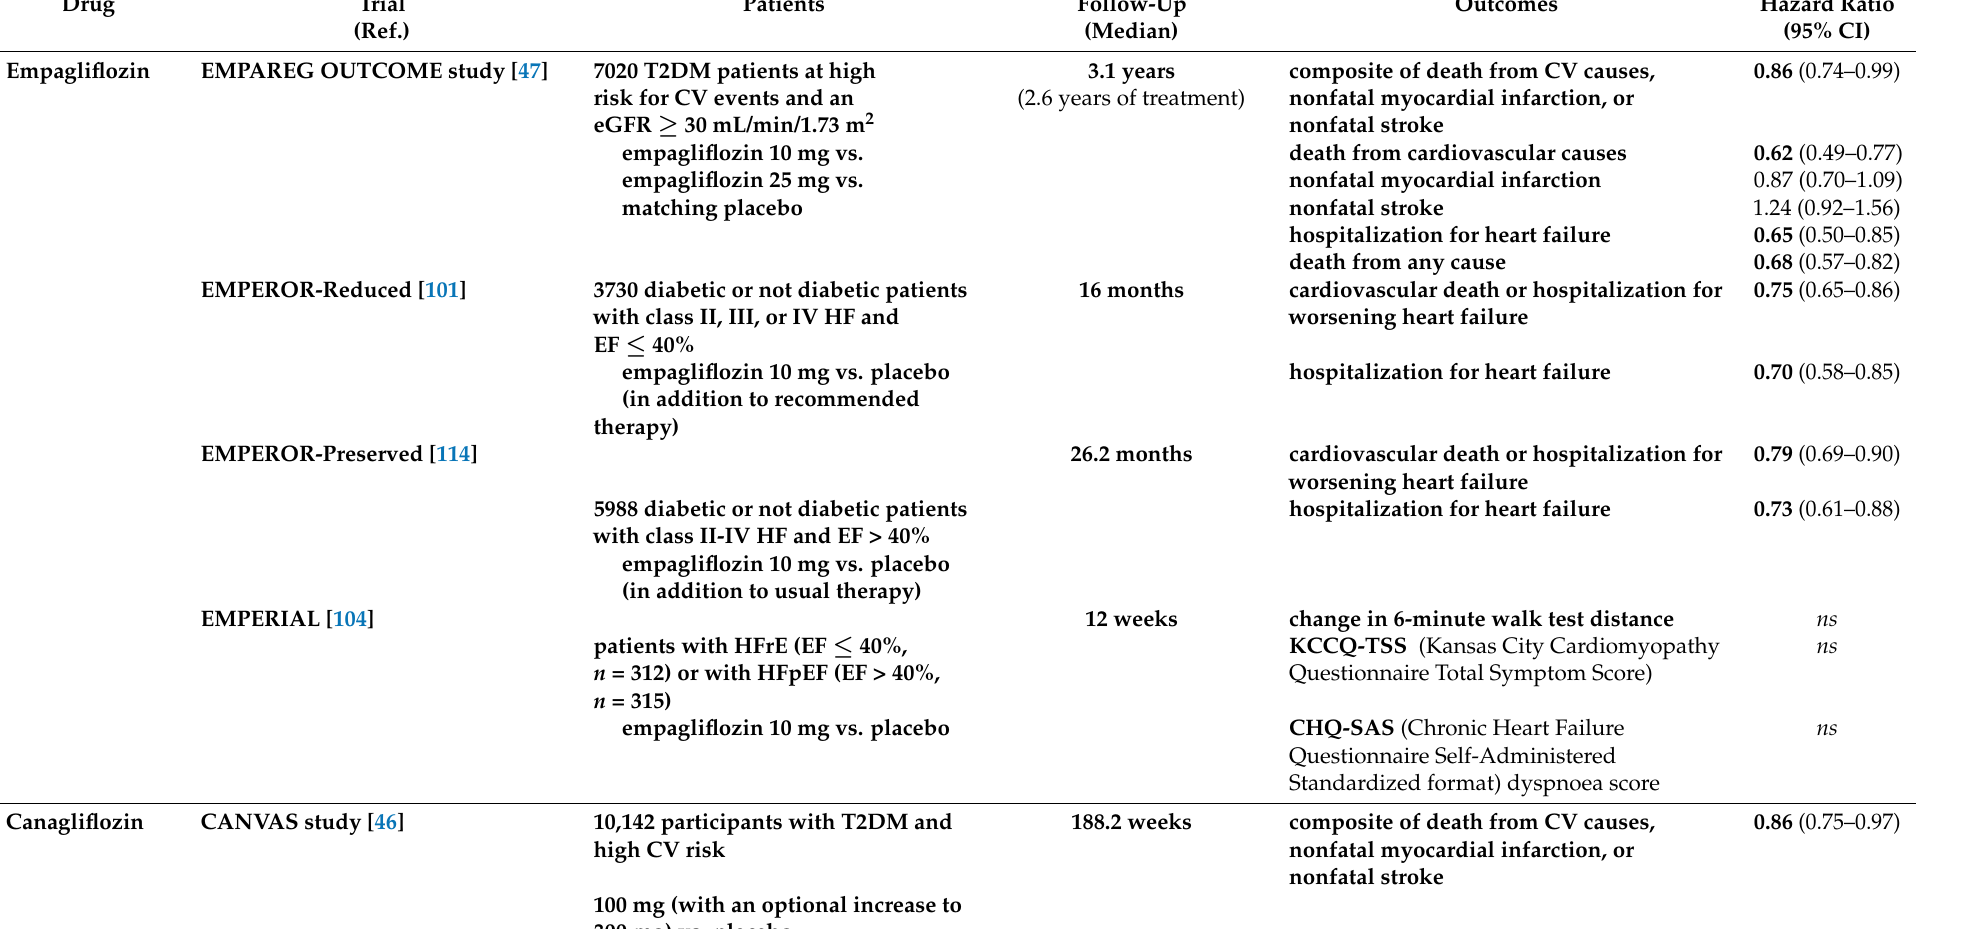
Table 1. Main clinical trials evaluating cardiovascular outcomes among patients treated with